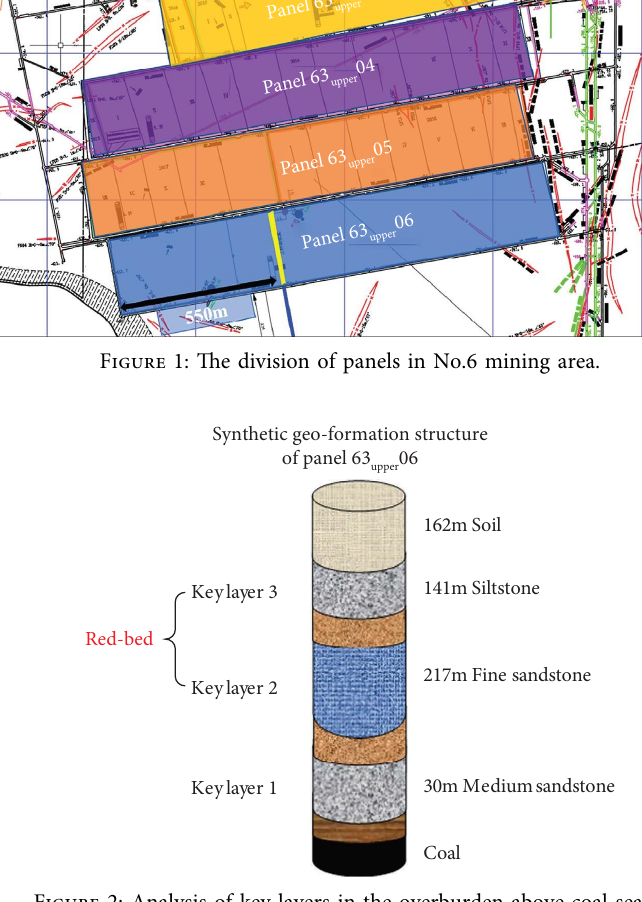
Figure 2: Analysis of key layers in the overburden above coal seam.